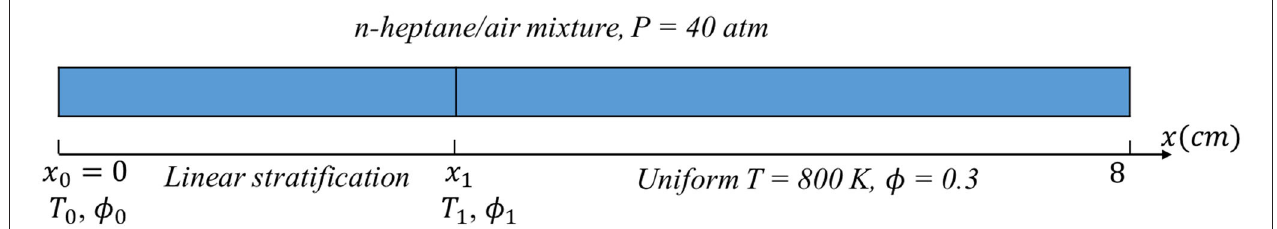
FIGURE 1 | 1-D Computational domain to investigate stratified combustion.